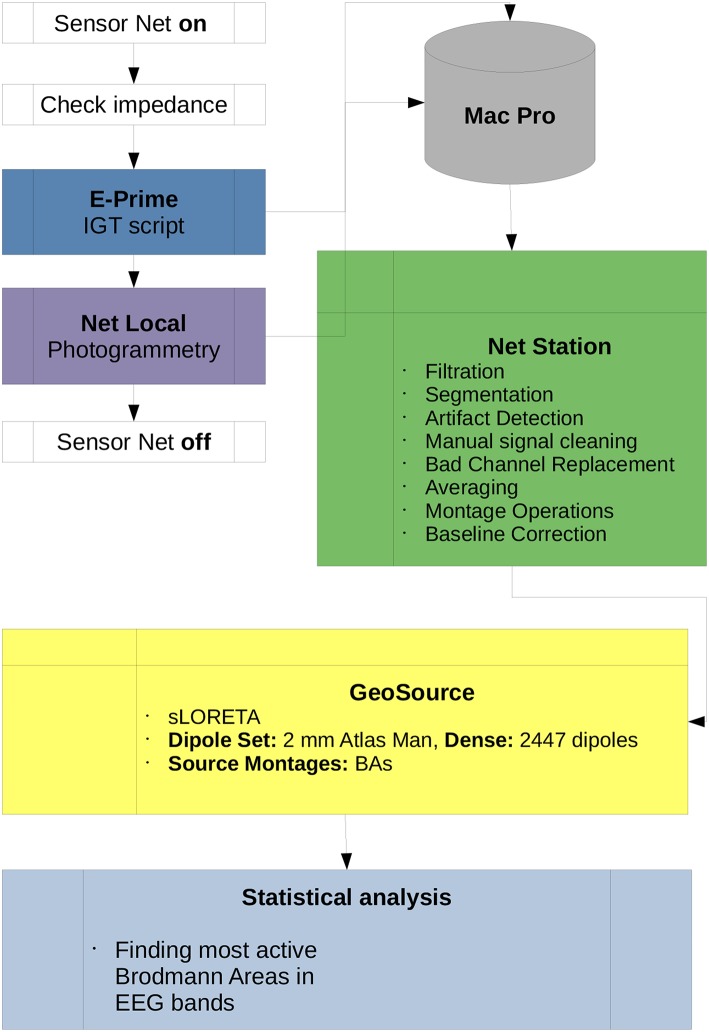
Diagram of the IGT research protocol used in this paper. All scripts used for the preprocessing data in Net Station and post-processing in GeoSource are listed. Participation of the subject in the experiment begins when the Sensor Net is put on and ends when it is taken off. All data is collected by the Mac Pro workstation which is the central computational unit of the lab. Statistical analysis, finding the most active BAs in full or each of α, β, γ, δ, and θ frequency bands as well as ι estimations can be conducted on other machines.